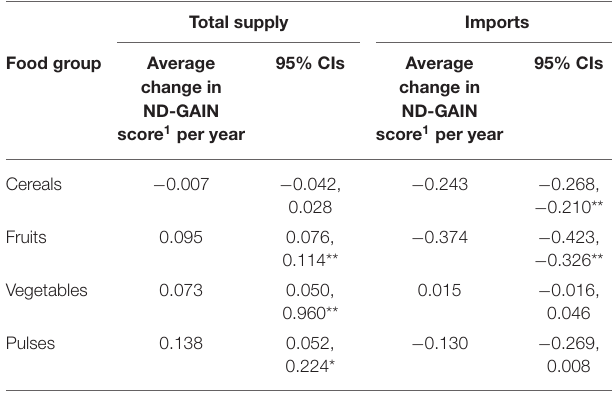
TABLE 1 | Multilevel mixed-effects generalized linear model for weighted-average change in ND-GAIN score (climate vulnerability) of total supply and imports for cereals, fruits, vegetables, and